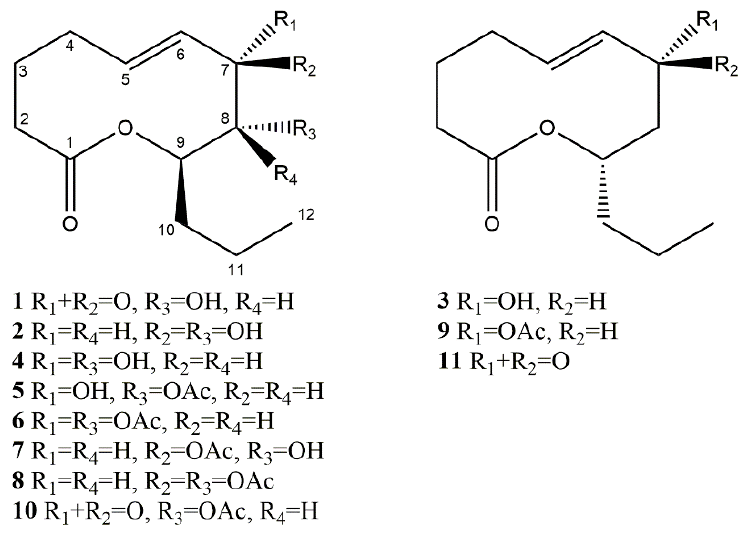
Figure 1. Natural nonenolides from S. cirsii (stagonolides A ( 1 ), J ( 2 ), K ( 3 ), herbarumin I ( 4 )) and their semi-synthetic derivatives: 8-acetylherbarumin I ( 5 ), bis(acetyl)herbarumin I ( 6 ), 7-acetylstagonolide J ( 7 ), bis(acetyl)stagonolide J ( 8 ), acetylstagonolide K ( 9 ), 8-acetylstagonolide A ( 10 ), С -7 oxidized stagonolide K ( 11 ).